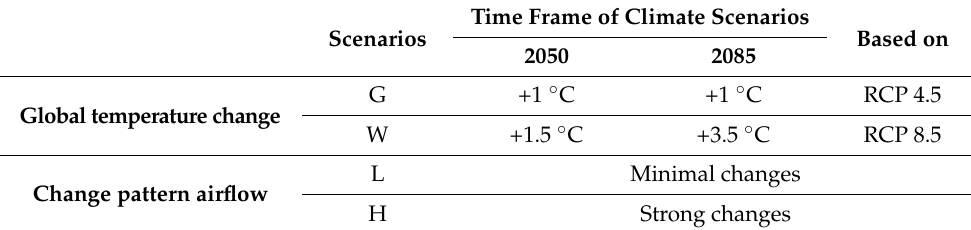
Table 3. Values of the climatic variables that give rise to the KNMI14 climate scenarios